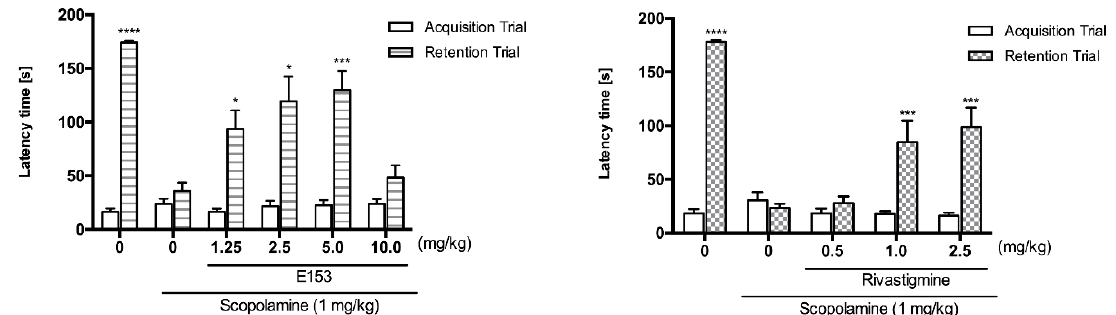
Figure 12. Activity of 19 ( E153 ) and rivastigmine in the Passive Avoidance Task. 19 ( E153 ) (1.25, 2.5, 5.0 or 10 mg/kg, i.p.) or rivastigmine (0.5, 1.0 or 2.5 mg/kg, i.p.) at the same volume of vehicle (1% Tween 80) was administered 30 min before the acquisition trial. Memory impairment was induced by scopolamine (1 mg/kg, i.p.) 20 min before the acquisition trial. 24 h after the acquisition trial, a retention trial was conducted for 180 s. Data represent means ± SEM (n = 7–9 per group); * p < 0.05, *** p < 0.001, **** p < 0.0001 versus the scopolamine-treated group. Statistical analysis: two-way ANOVA fol- lowed by Tukey ’ s Multiple Comparison Test.